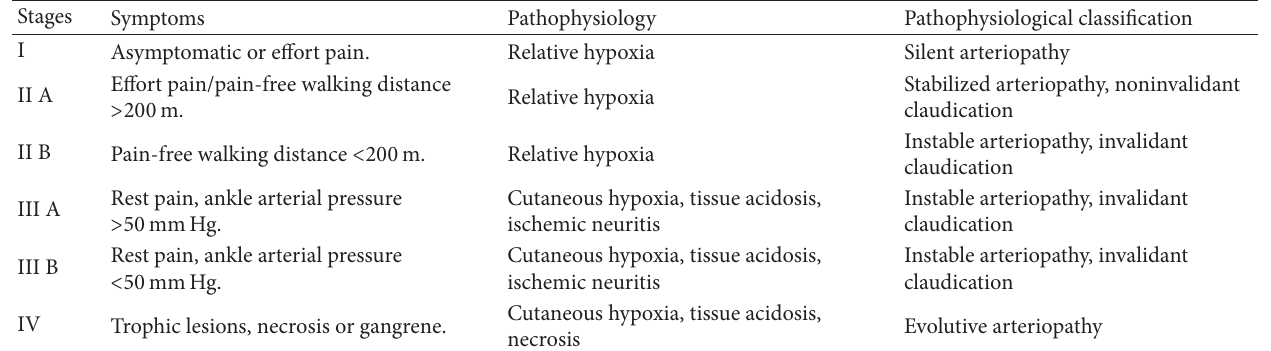
Table 2: Leriche-fontaine classification.